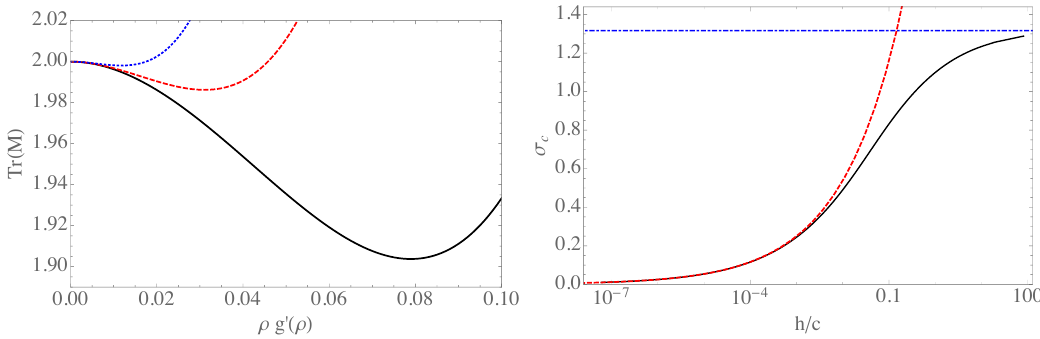
Figure 1 . Left: the trace of the monodromy matrix M computed numerically as a function of (cid:26) and (cid:26)g 0 ( (cid:26) ), for three values of (cid:26) : (cid:26) = 0 : 4 (black, solid) , (cid:26) = 0 : 5, (red, dashed) , and (cid:26) = 0 : 6, (blue, dotted) . Right: the critical value of (cid:27) (black, solid) where the semiclassical part of the c correlator (cid:12)rst develops an imaginary piece, as a function of h=c . For comparison, we show (red, p 3 h=c ) 1 = 3 from (3.23), and (blue, dot-dashed ) the dashed ) the analytic small h=c behavior, (cid:27) c (cid:25) (9 large h behavior (cid:27) c log(2 + p 3), from (cid:25)